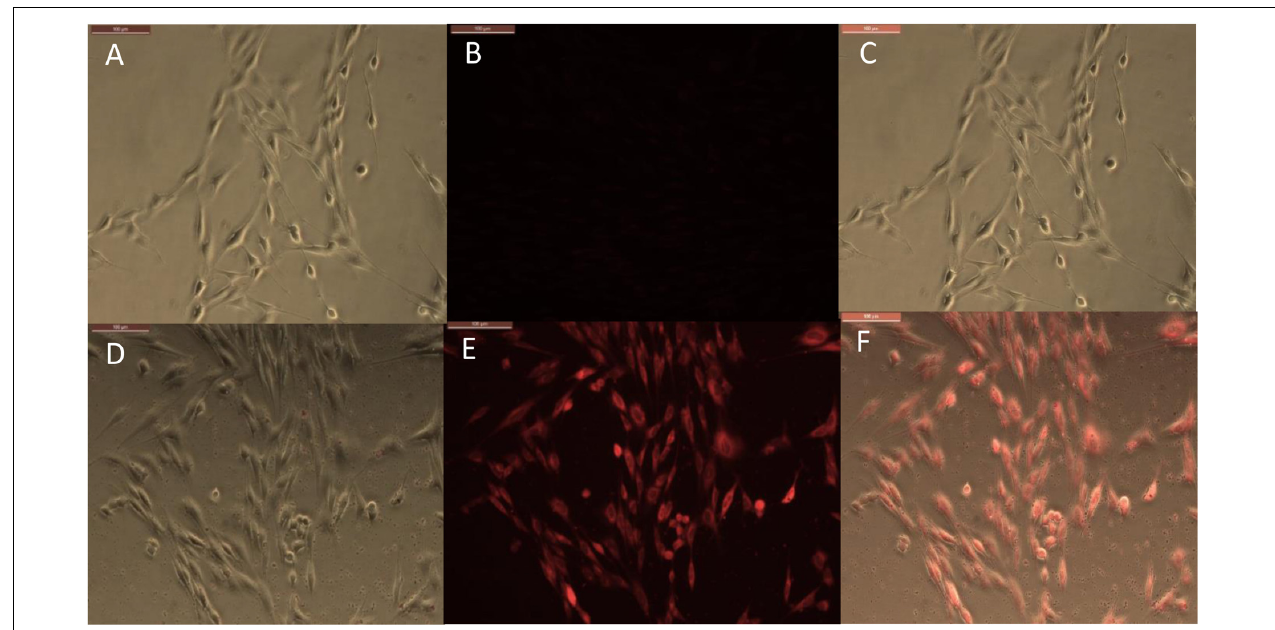
FIGURE 3 | Phase and fluorescence imaging of primary brain endothelial cells treated with RITC only (A,B) , and with halloysite clay nanotubes loaded with RITC (D,E) after 30 min exposure. Merged images for the phase and fluorescence settings (C,F) . Magnification 200X, scale bar = 200 µ m.